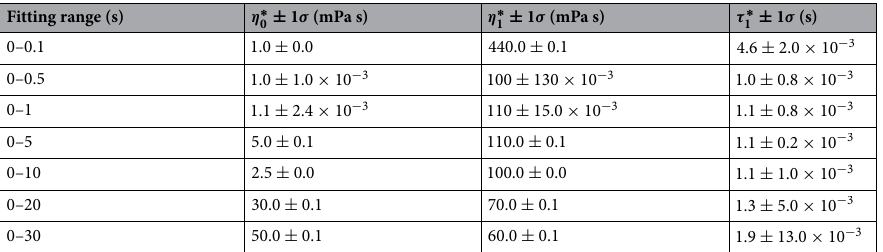
Table 1. Parameter estimated from simulated time series of T s /τ 1 = 2000 and time step � t /τ S = 0.1 by fitting the corresponding ACF over various range of time lags. Clearly, the estimations are close to all the input parameters when the fitting range lies in between from 0–0.5 to 0–1 s. The input parameters in the simulation are the same as in Fig. 1.